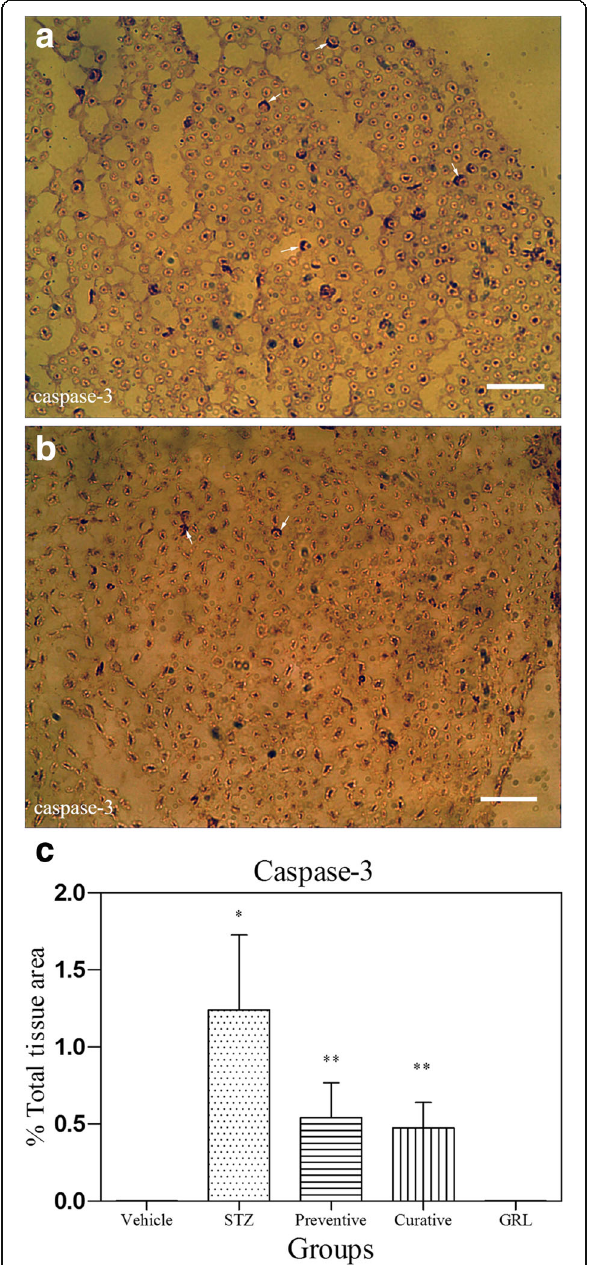
Fig. 5 Light Photomicrographs show immunohistochemical expression of COX-2 in STZ ( a ) and STZ plus GRL ( b ) groups (original magnification: ×400, bar: 250 μ m). The positive staining of COX-2 is presented by a brown color of cytoplasm (arrows). Densitometry analysis of immunohistochemical photomicrographs for COX-2 was assessed. Data are expressed as a percentage of total tissue area ( c ) of 7 rats/group. * P < 0.001 versus vehicle and GRL group; ** P < 0.001 versus STZ group by one-way ANOVA followed by Tukey ′ s post-hoc